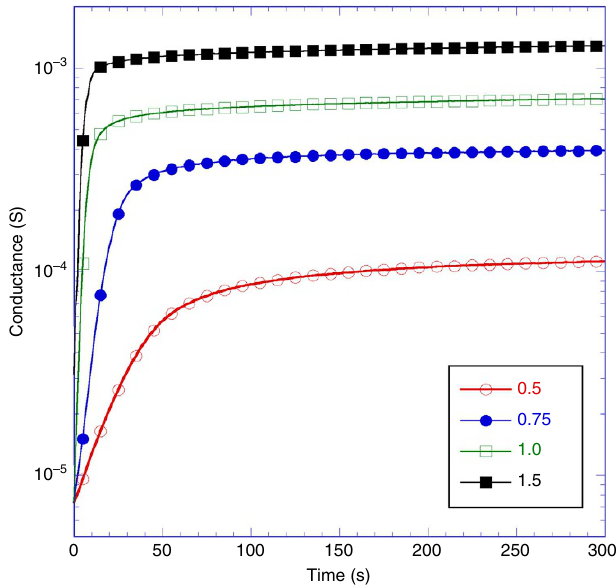
Figure 2 | Field-induced electrical conductance increase. Time-dependent increases in conductance were observed at different measurement voltages. Voltage V 23 was held constant at the values indicated in the legend (in Volts), while flowing current between electrodes 1 and 7. The electrode configuration is shown in Fig. 1. The conductance is enhanced by a factor of 190 at the highest voltage (field) shown. The measurements were taken at 370 (cid:2) C, with the sample equilibrated at p O 2 ¼ 150